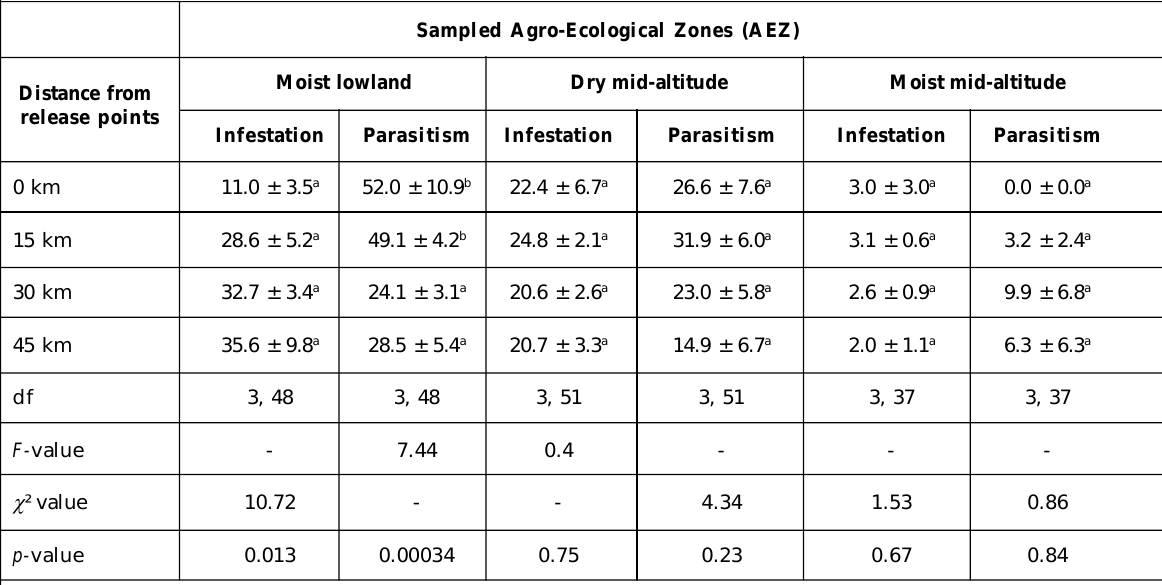
Table 3: Mean plant infestation and stem borer parasitism ( x — +SE ) in different AEZs